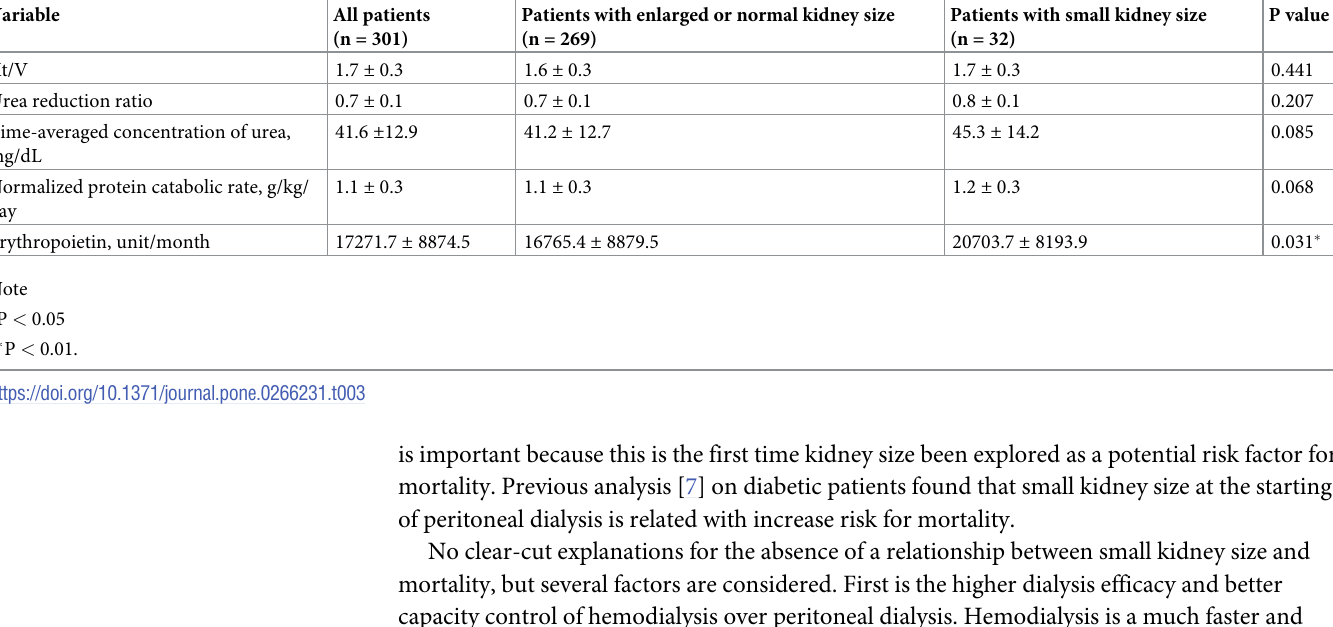
Table 3. Dialysis related data of diabetic patients receiving hemodialysis stratified by kidney size (n = 301). Variable